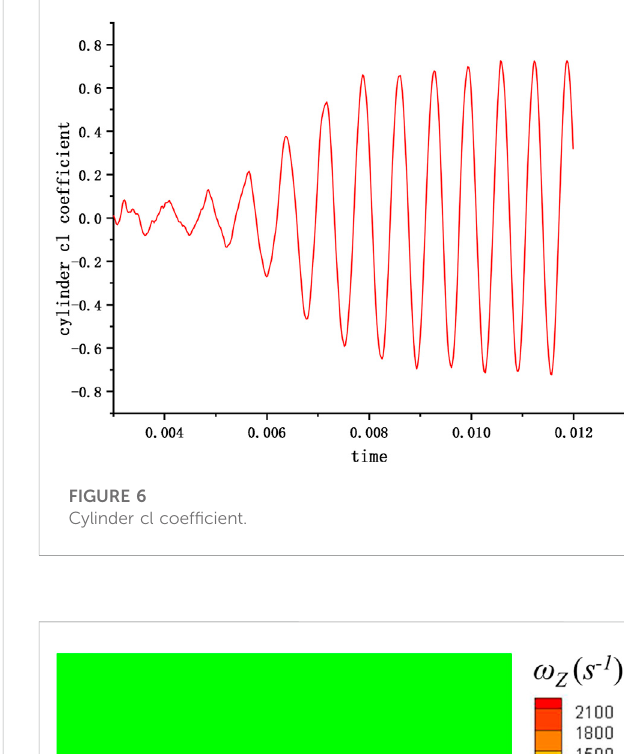
FIGURE 6 Cylinder cl coef fi cient.